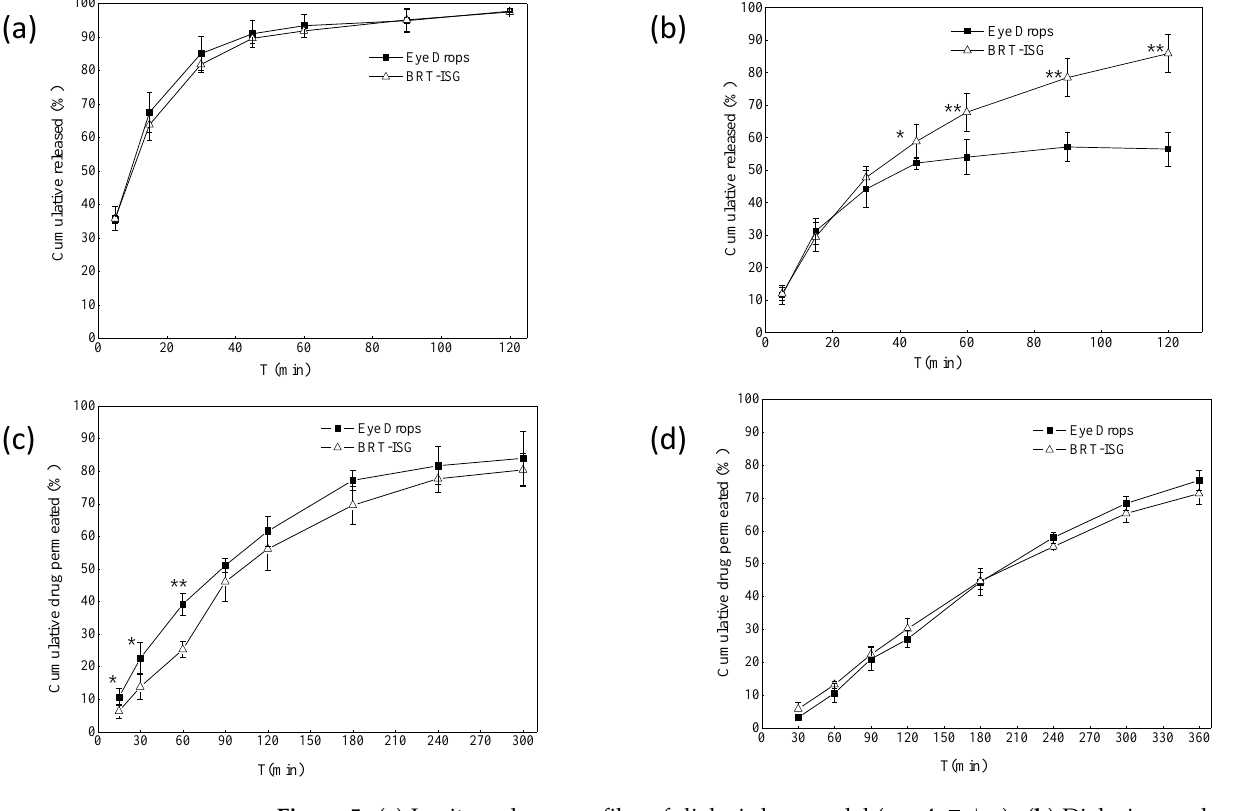
Figure 5. ( a ) In vitro release profiles of dialysis bag model ( n = 4, x ± s). ( b ) Dialysis membrane permeation profile ( n = 6, x ± s). * p < 0.05 BRT-ISG vs. eye drops at 45 min, ** p < 0.01 BRT-ISG vs. Eye Drops at 60, 90, 120 min. ( c ) Ex vivo transscleral permeation profile ( n = 5, x ± s). * p < 0.05 BRT-ISG vs. eye drops at 15, 30 min, ** p < 0.01 BRT-ISG vs. eye drops at 60 min. ( d ) Ex vivo transcorneal permeation profile ( n = 5, x ± s).